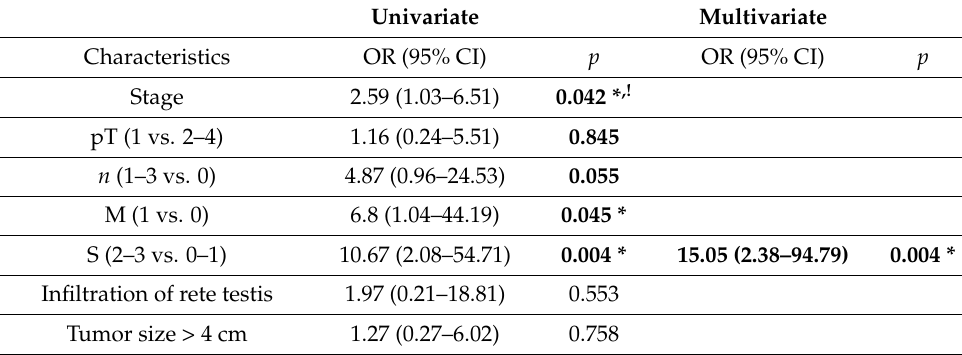
Table 5. Univariate and multivariate logistic regression analysis of factors predicting event